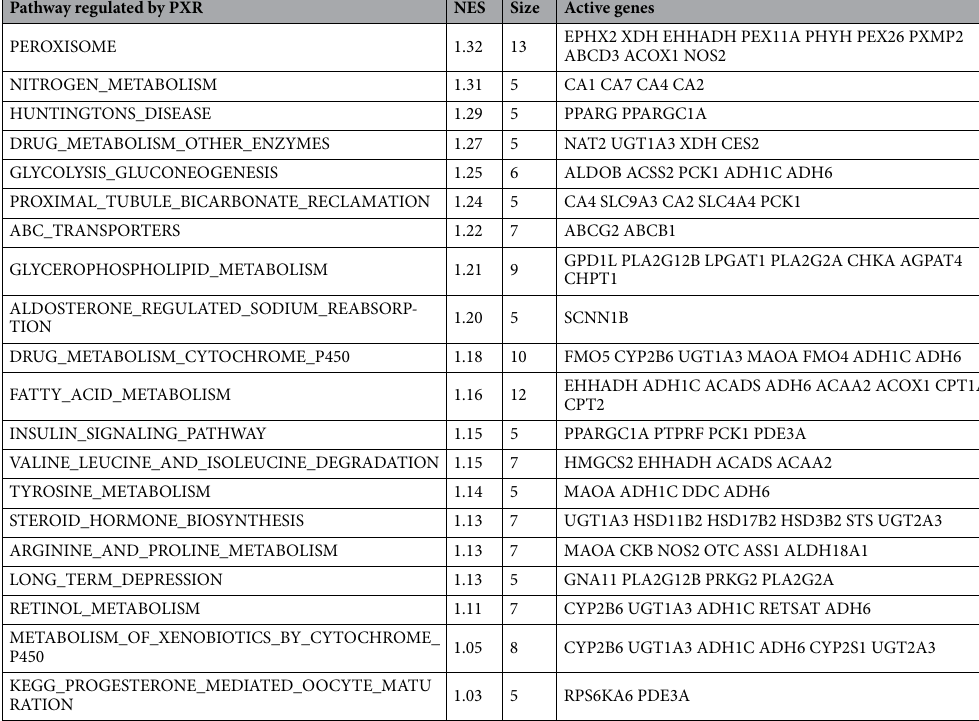
Table 1. Biological signal pathways and active genes in PXR high expression group by